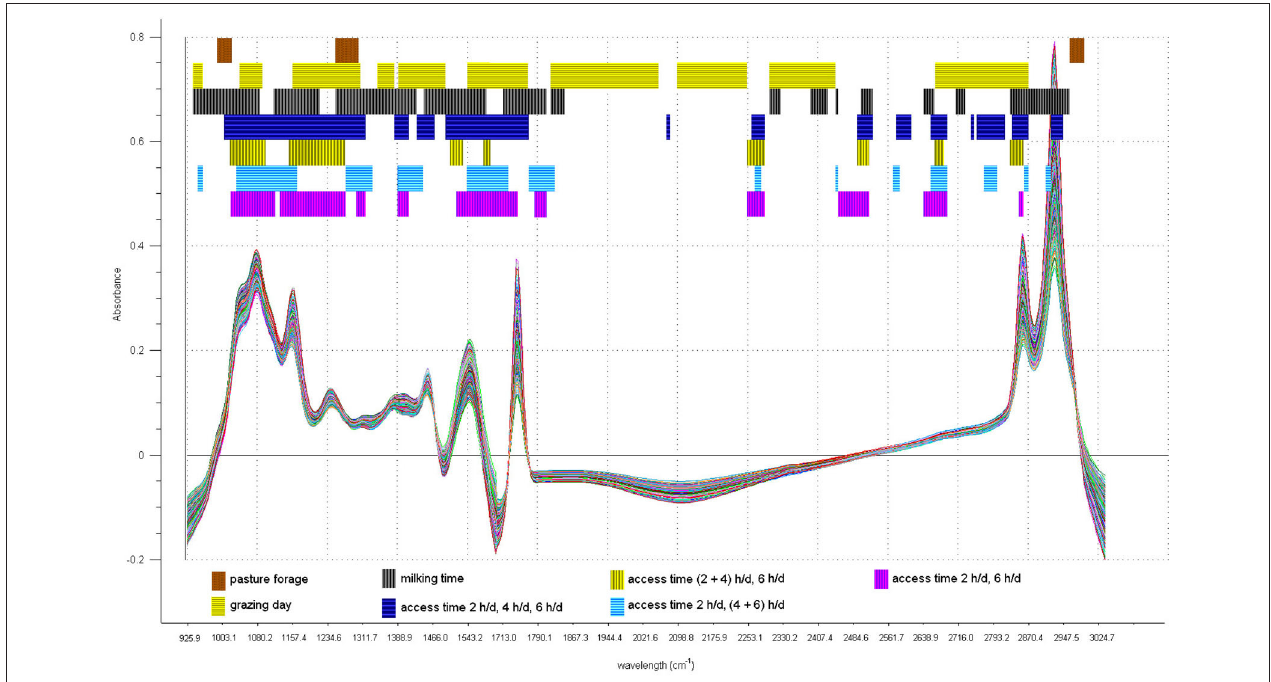
FIGURE 5 | Spectral regions selected by genetic algorithm (GA) in all the GA-linear discriminant analysis (LDA) discrimination